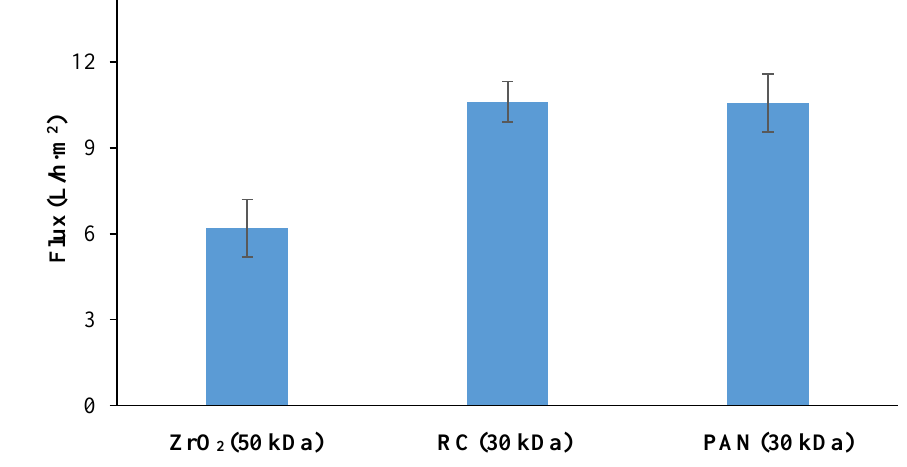
Figure 2. Constant permeate flux (VRF: 2) of tomato aqueous extract through 50 kDa zirconia (ZrO 2 ), 30 kDa RC, and 30 kDa PAN membranes.